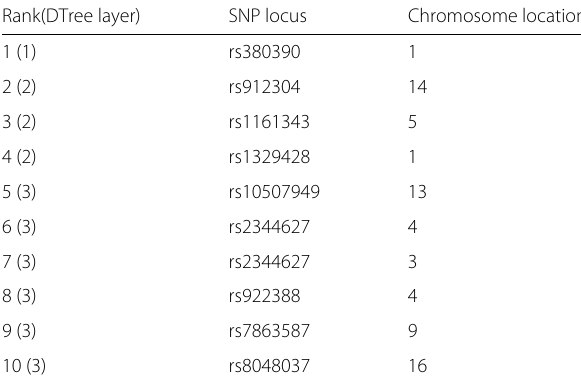
Table 3 Epistasis results on the dataset